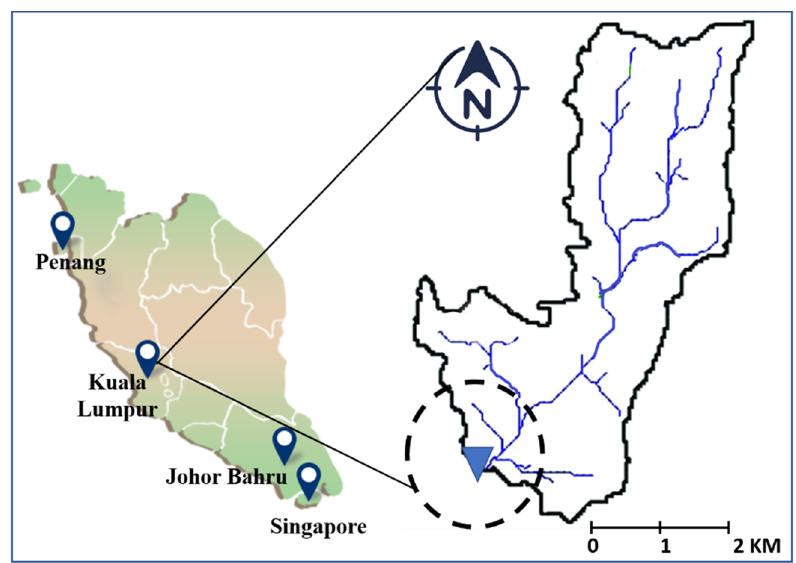
Figure 1. Location of Sungai Kayu Ara Watershed in Kuala Lumpur, Malaysia.